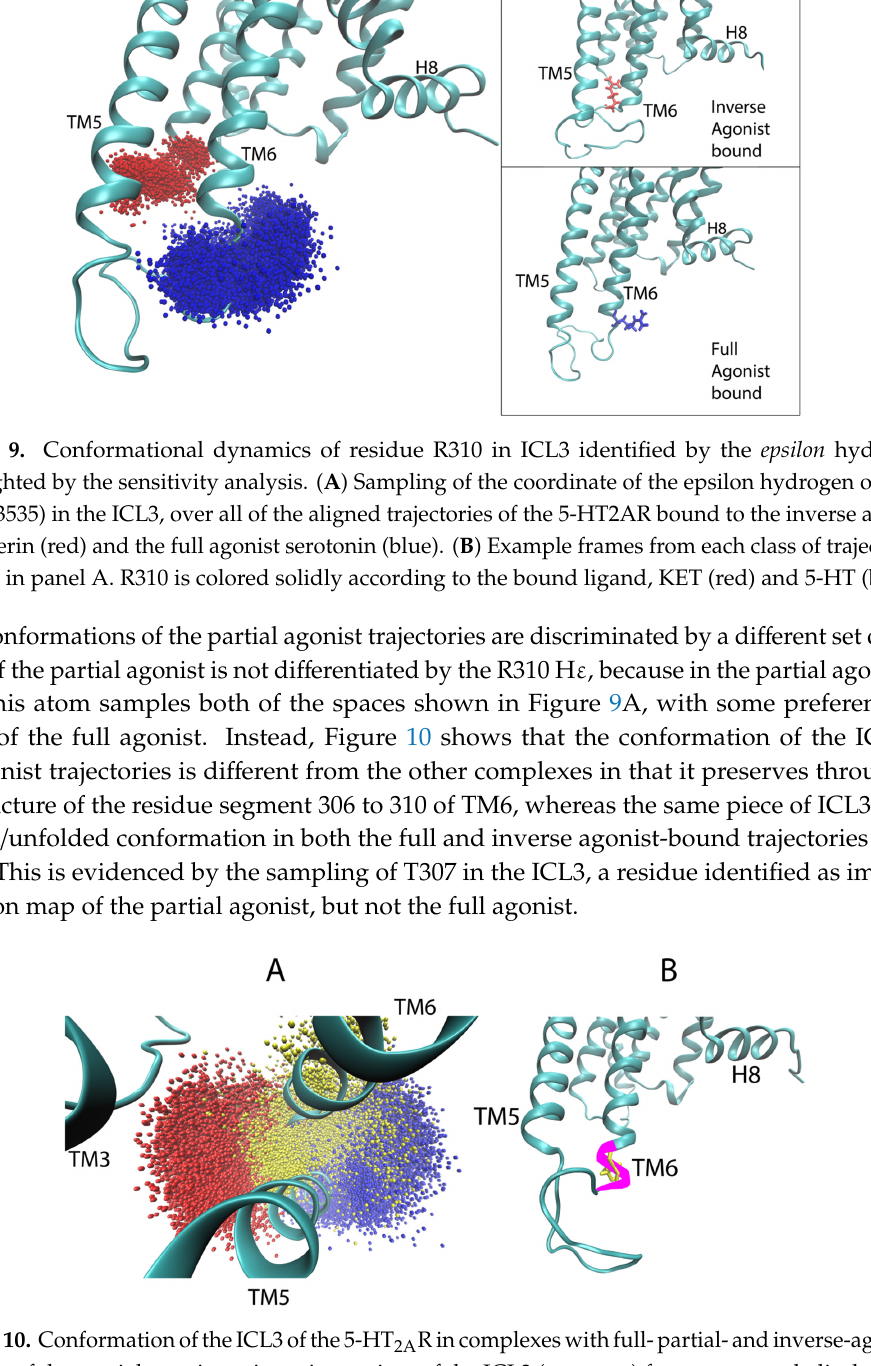
Figure10. ConformationoftheICL3ofthe5-HT 2A Rincomplexeswithfull-partial-andinverse-agonists. In most of the partial agonist trajectories, a piece of the ICL3 (magenta) forms an extra helical turn of TM6. In the full and inverse agonist-bound trajectories, this piece of the ICL3 is disordered / unfolded, with T307 pointing inwards towards TM3 in the inverse agonist trajectories and pointing away from TM3 in the full agonist-bound trajectories. ( A ) The sampling of the coordinate of the gamma oxygen of T307, an atom identified as important in the attention map of the partial agonist, for all the trajectories of the 5-HT 2A R bound to full agonist (in blue), inverse agonist (red), and partial agonist (yellow). ( B ) Illustrative frame from partial agonist-bound trajectories showing the extended helical conformation of the ICL3. T307 is colored in yellow and the extra helical turn is colored in